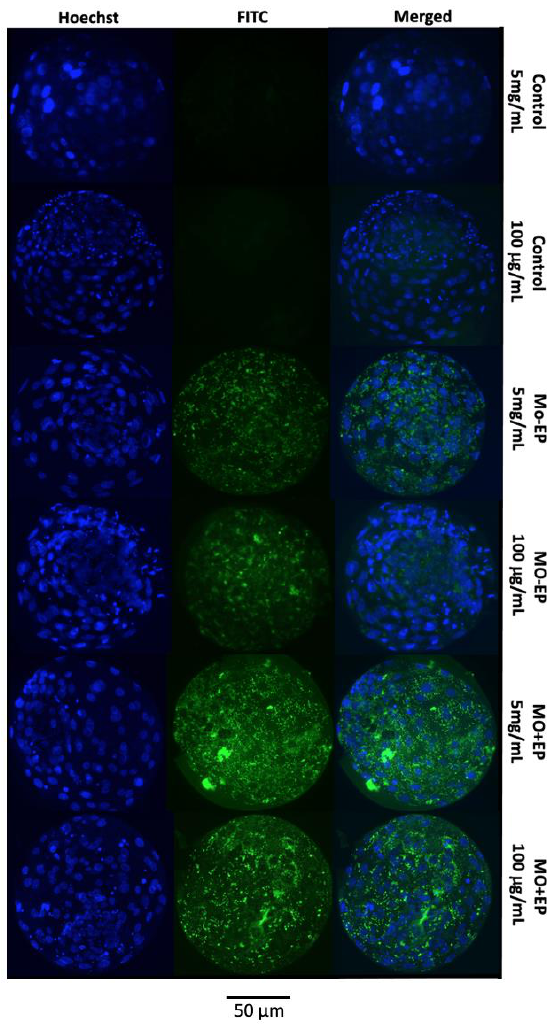
Figure 2. Representative panel of in vitro-produced expanded blastocysts from the control, morpholino (Mo) coupled to the fluorescein isothiocyanate (FITC) probe (designed by GeneTools for a human β -globulin gene and not present in bovines) in the absence (Mo − EP) or presence (Mo + EP) of the endo-porter delivery system supplemented with 5 mg/mL or 100 µ g/mL of bovine serum albumin (BSA). Blue staining (Hoechst 33342) indicates the location of the nucleus of the embryonic cells. Green staining indicates morpholino coupled to the FITC fluorescence probe within the embryonic